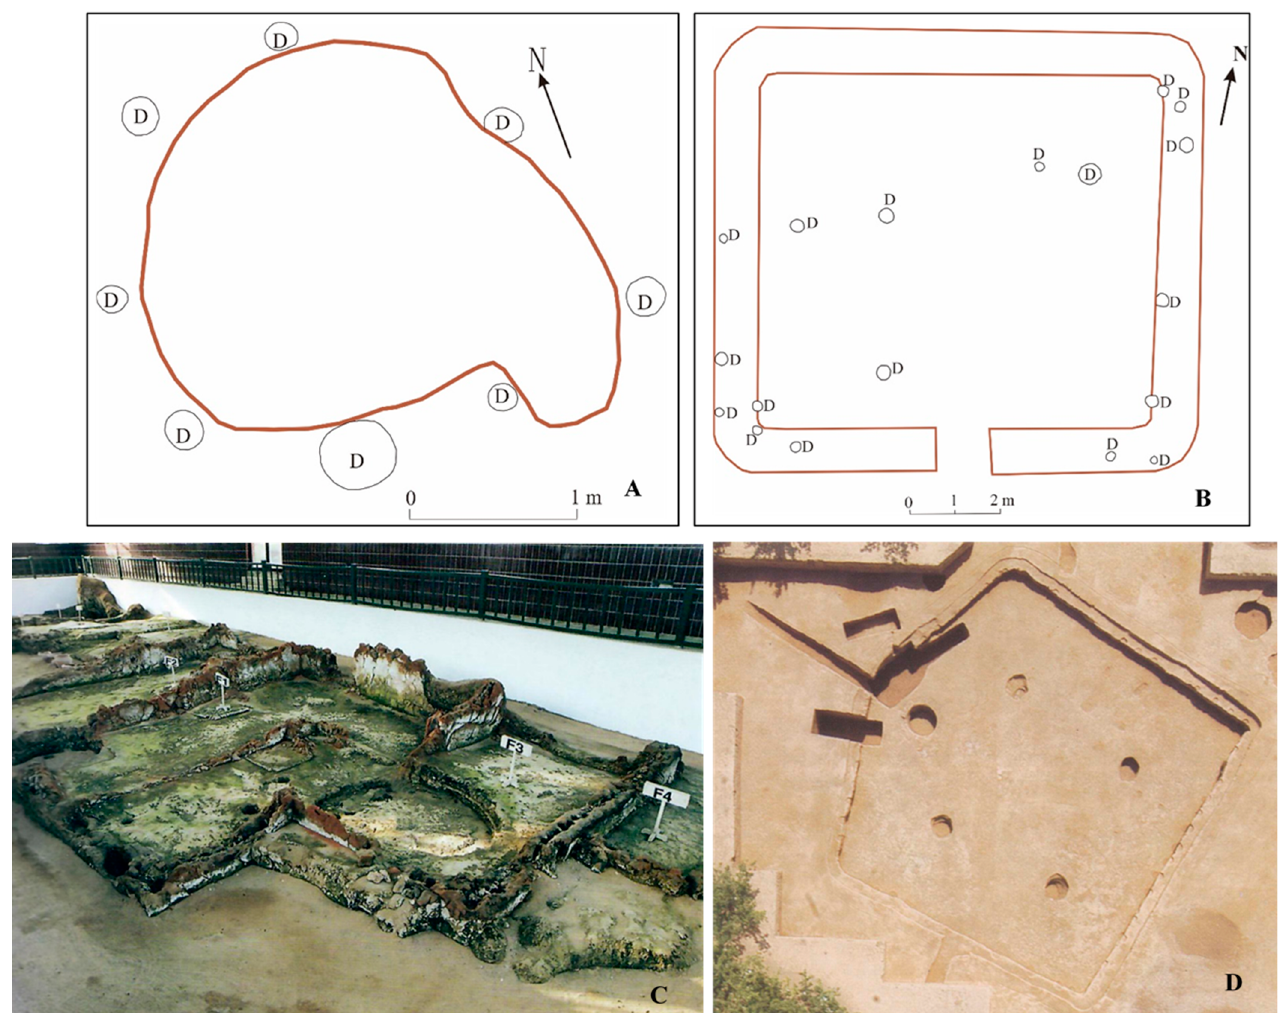
Figure 3. The floor plans and photos of the early houses. ( A ) The floor plans of the round semi pithouse; it was redrawn from F21 of the Tanghu site [10]. D = pillar hole. ( B ) The floor plans of surface building; it was redrawn from F74 of the Jiangzhai site [11]. D = pillar hole. ( C ) The floor photo for F1–4 of the Dahecun site, it cites from ZICRA (2001) [12]. ( D ) The floor photo for F106 of the Xipo site, it cites from Li XW et al (2015) [13].